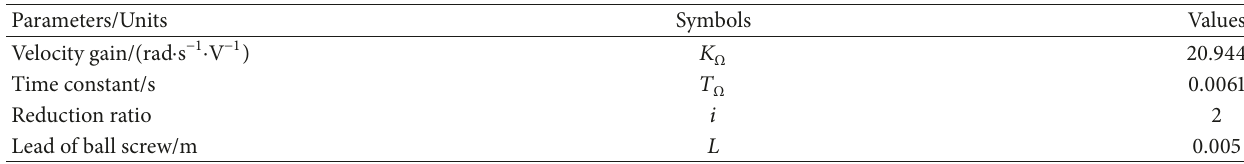
Table 1: Main parameters of experimental platform.